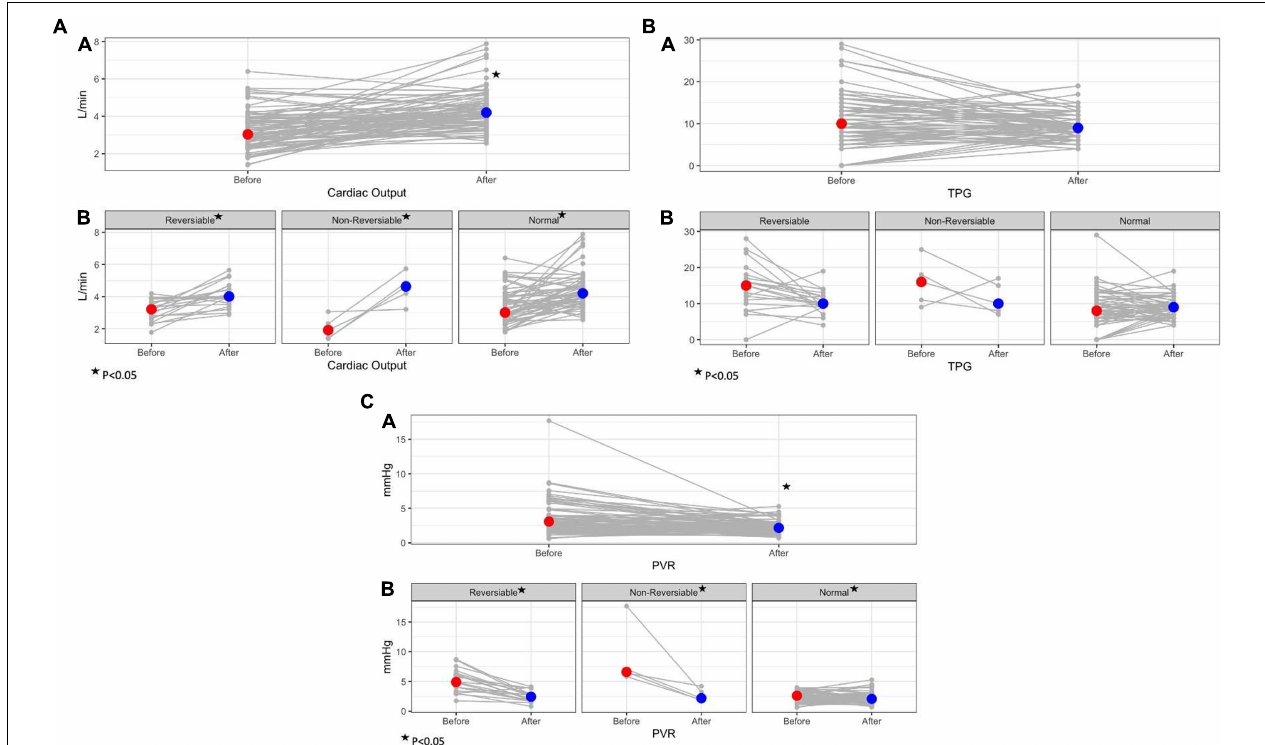
FIGURE 1 | Trends in hemodynamic parameters before and after LVAD implantation surgery according to baseline PVR. (A) Trends in cardiac output before and after LVAD; A- overall study cohort; B- study groups according to baseline PVR. (B) Trends in total pulmonary gradient (TPG) before and after LVAD; A- overall study cohort; B- study groups according to baseline PVR. (C) Trends in pulmonary vascular resistance (PVR) before and after LVAD; A- overall study cohort; B- study groups according to baseline